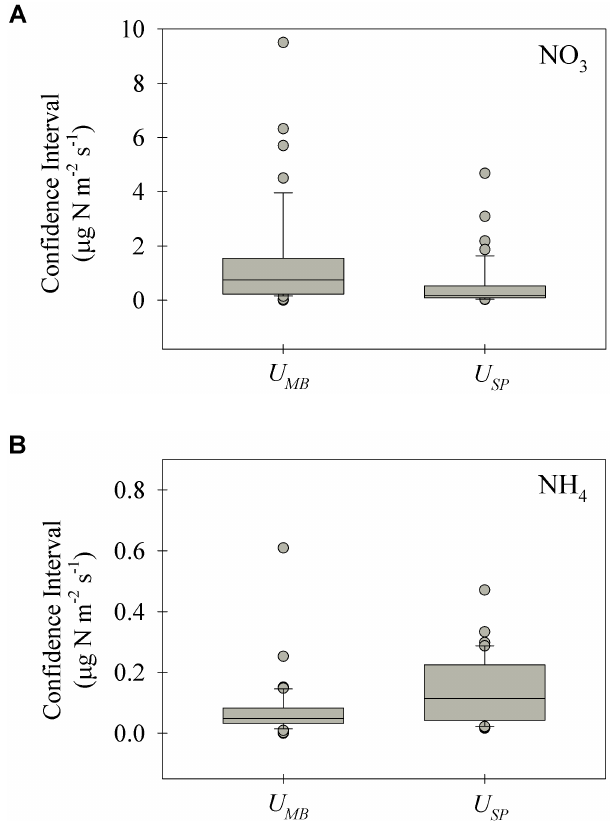
Fig. 3. Sensitivity analysis of the influence of (A) average stream water N concentration and (B) reach length on the absolute dif- ference between net uptake rates estimated with the mass bal- ance approach ( U MB ) and the spiralling approach ( U SP ) . Constant discharge (10ls − 1 ) and wetted width (2m) were considered be- tween only two stream stations (top and bottom). In (A) reach length = 100m, and in (B) average N concentration = 200µgNl − 1 . Numbers on each dashed line correspond to different proportions of stream N concentration between the top and bottom stations.